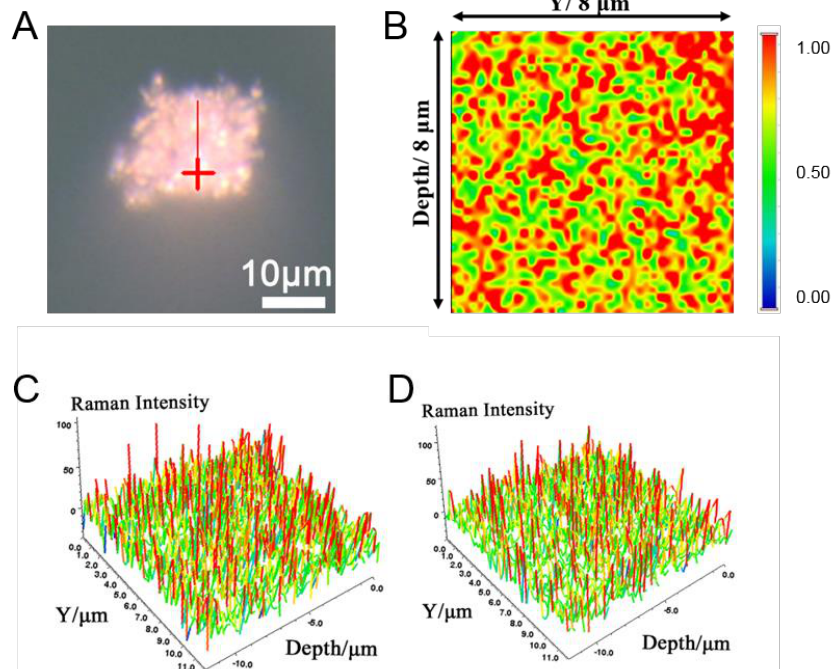
Figure 5. ( A ) Optical micrograph of a single particle of granular porous Ag. ( B ) Longitudinal Raman mapping along the red line in ( A ). ( C ) Distribution of the SERS intensity at the 613 cm − 1 peak. ( D ) Distribution of the SERS intensity at the 1127 cm − 1 peak.